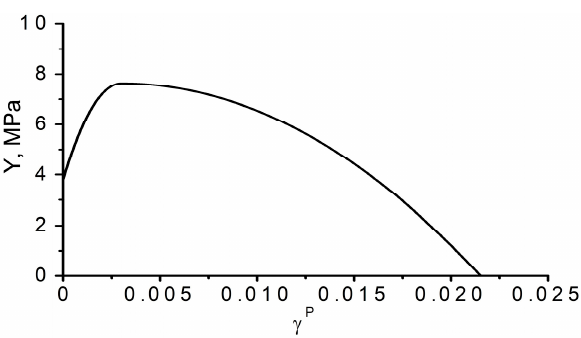
Figure A5. Evolution of cohesion in the course of inelastic strain accumulation.